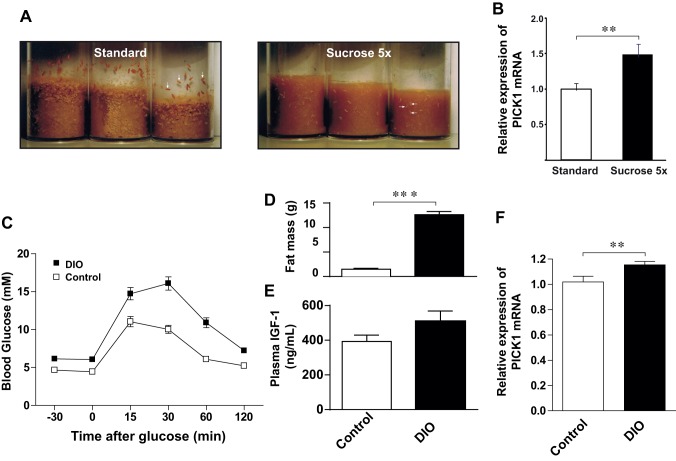
Up-regulation of PICK1 expression in Drosophila under HSD that induces peripheral dILP resistance.(A) Delayed larval development in response to HSD that induces peripheral dILP resistance [38],[39]. WT flies were allowed to deposit eggs on an apple juice plate for 6 h. On the following day, first instar larvae hatched from the eggs were transferred to vials either containing food with the standard amount of sucrose (left) or five times that amount (right). Photographs were taken 6 d following oviposition. Note that, when all the larvae in the vials containing standard food have already left the food, completed the wandering stage, and commenced pupariation (left, vertical arrows), the larvae in the vials with 5× sucrose have yet to leave the food to commence the wandering stage (right, horizontal arrows). (B) Quantitative RT-PCR was performed on pooled heads from fully developed adult female flies reared on standard food (n = 9 samples) or food with five times the normal amount of sucrose (n = 7). Data show relative change (means ± SE). **p<0.01. (C) Impaired glucose tolerance in high-fat-diet-induced obese C57BL mice (DIO). OGTT was performed on DIO mice (black squares) and littermate controls fed on a normal chow diet (white squares). After 16 h fasting, the DIO mice displayed increased glucose level compared to control mice (6.1±0.3 mM versus 4.4±0.2 mM; p = 0.0006), and after the glucose load, the blood glucose level was significantly higher at any time point (p≤0.001). (D) The DIO mice also displayed significantly higher fat mass compared to control mice (12.6±0.6 g versus 1.48±0.21 g; ***p≤0.0001). (E) Total plasma level of IGF-1 in DIO mice (510±59 ng/mL) compared to control mice (393±37 ng/mL) (p = 0.11). (F) The relative expression of PICK1 mRNA assessed by RT-PCR was increased in the pituitaries of DIO mice. All measurements were performed on n = 14 high-fat-diet-treated mice and 14 mice fed a normal chow diet and data are expressed as means ±SE.